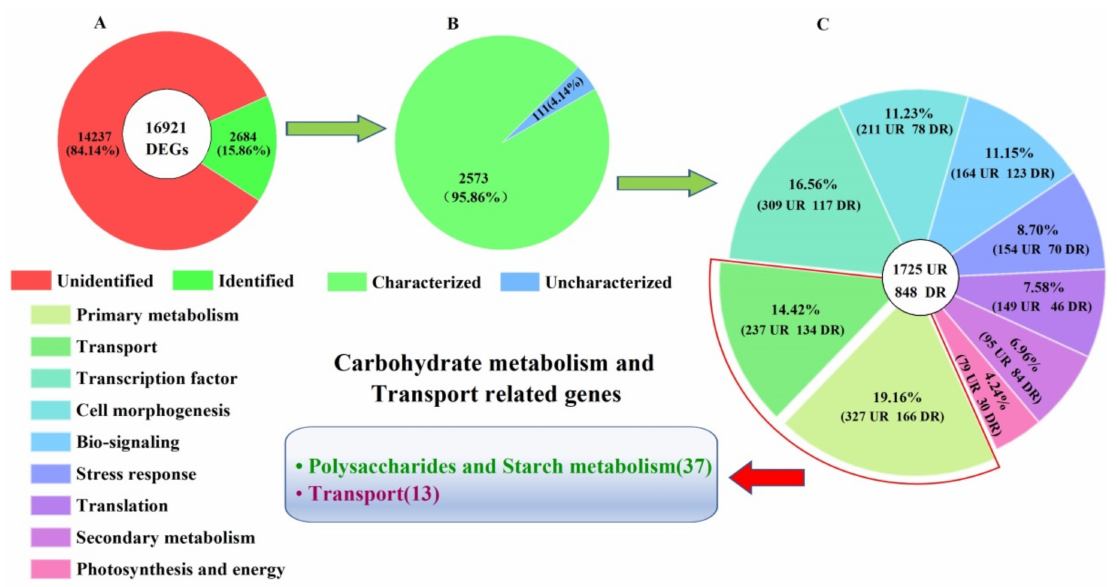
Figure 7. Distribution and classification of DEGs in the CR compared with CS (UR, up-regulation; DR, down-regulation). Image ( A ) represents the classification of unidentified and identified genes, image ( B ) represents the classification of uncharacterized and characterized genes and image ( C ) represents the classification of the functional genes.